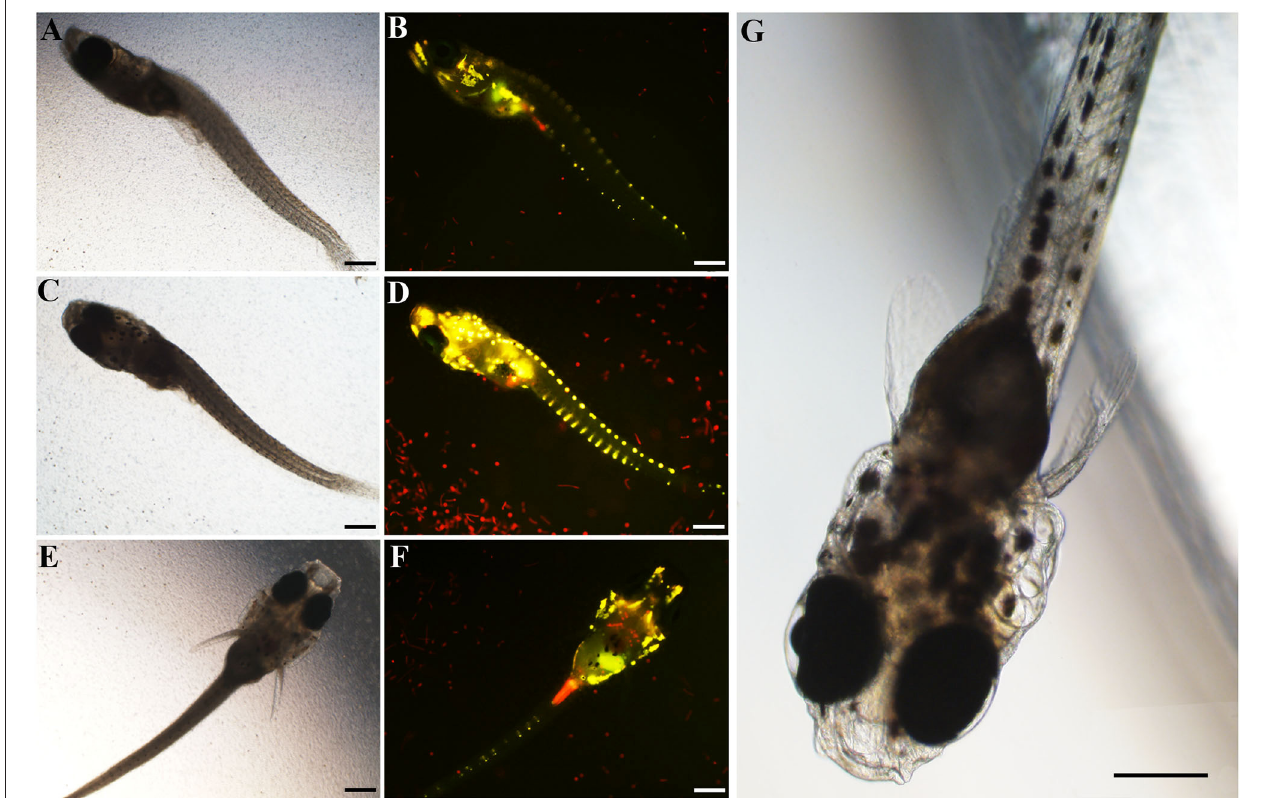
FIGURE 6 | The finfish marine medaka Oryzias melastigma used in the fish bioassays exposed to live cell culture of 16,000 cells · mL − 1 , bright field light microscopic micrographs (A,C,E) of the dead fish, and corresponding epifluorescent micrographs (B,D,F) . Normal larval finfish O. melastigma was showed in micrograph (G) . Scale bars = 200 µ